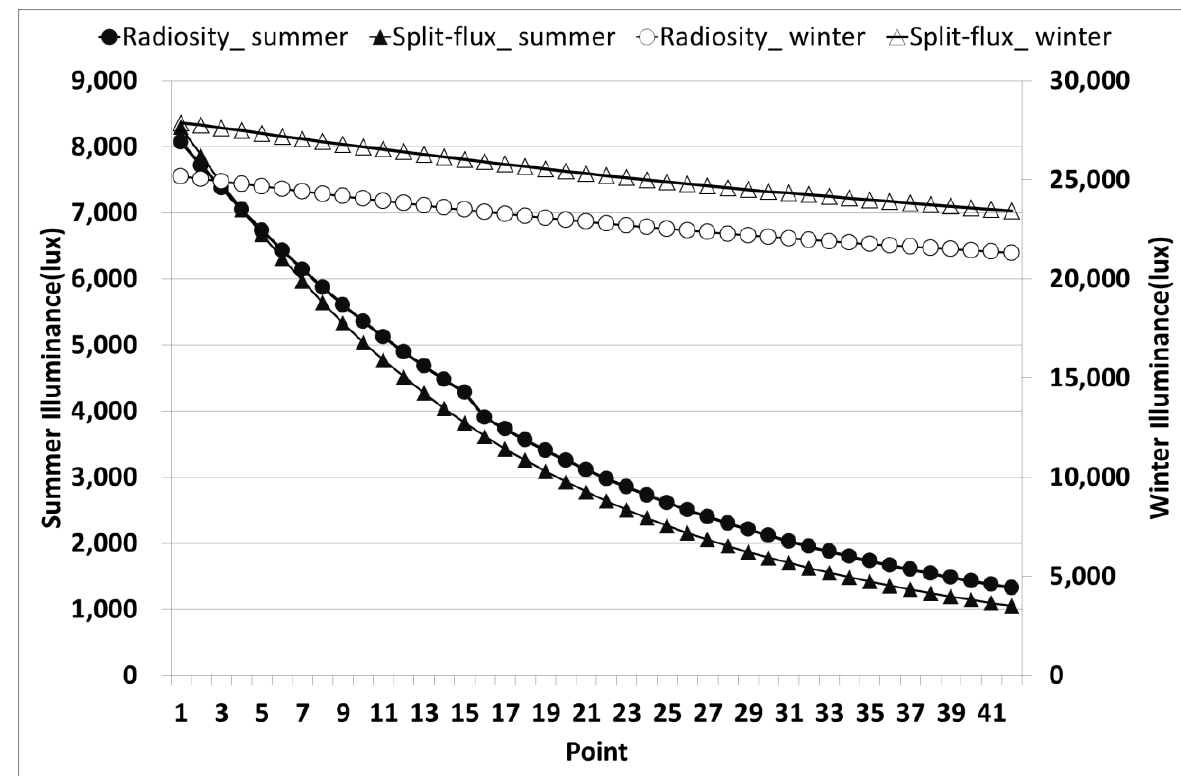
Figure 9. Analysis of illuminance level for direct sunlight conditions.